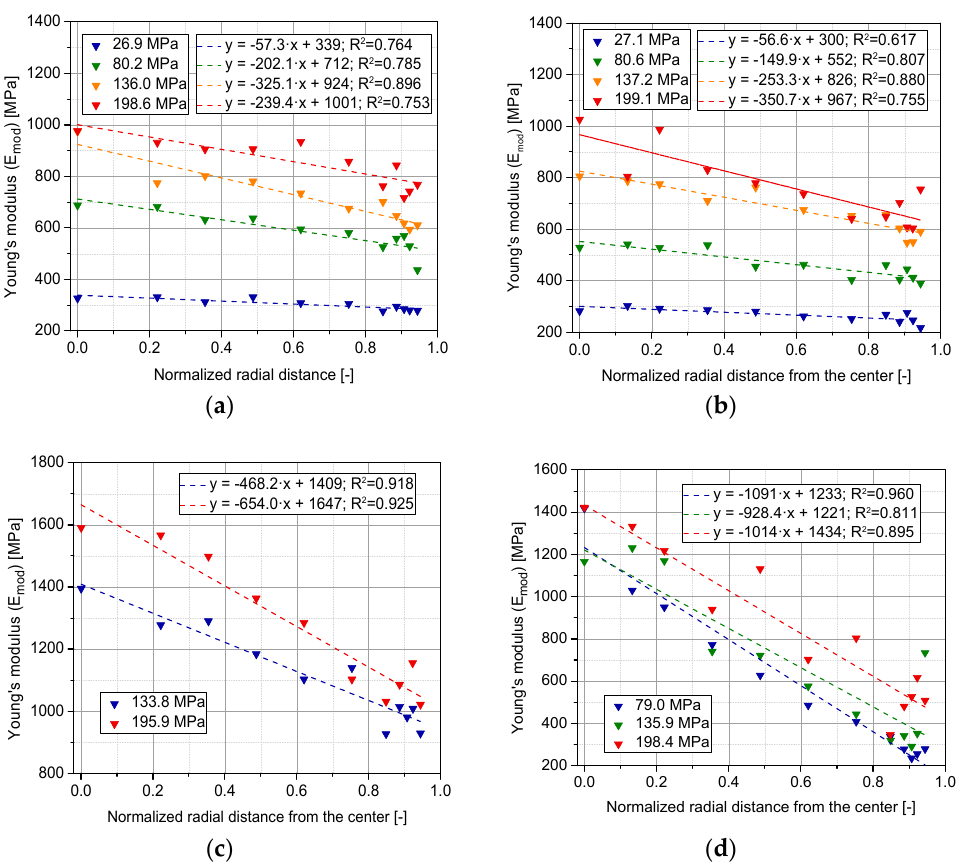
Figure 18. Radial evolution of E mod at the lower surface of the tablet for the following materials; ( a ) MCC-A; ( b ) MCC-P; ( c ) LAC; ( d ) CAPH. Sampling: eight tablets per SF and face, six indents at each radial distance.